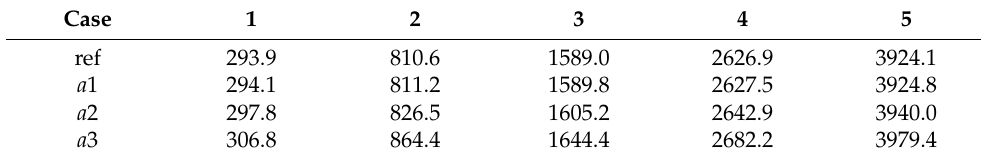
Table 5. The fi rst fi ve-mode frequencies under di ff erent static loads (Hz).